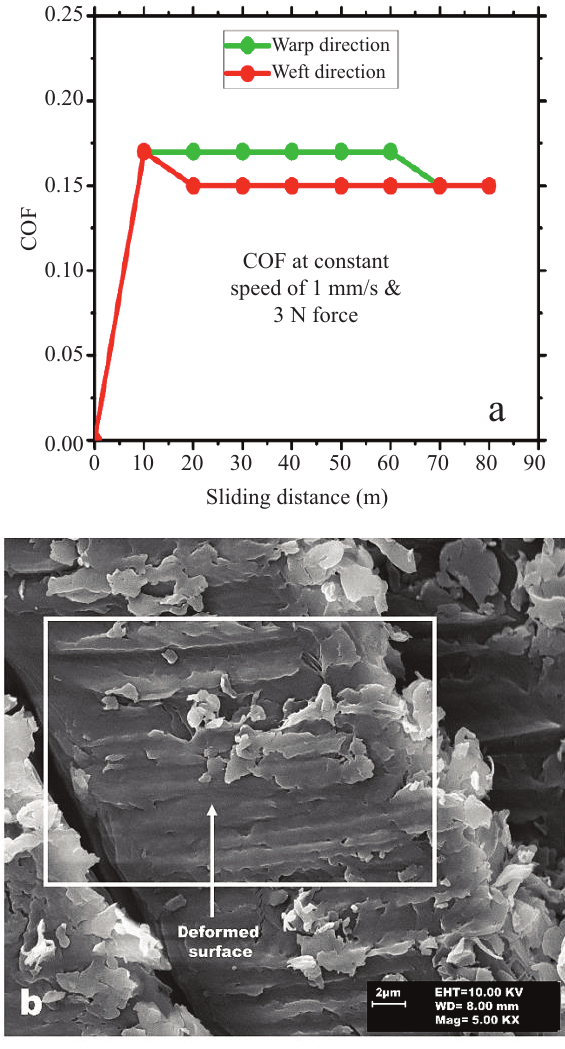
Fig. 6. (a) COF versus sliding distance observations and (b) SEM image of deformed